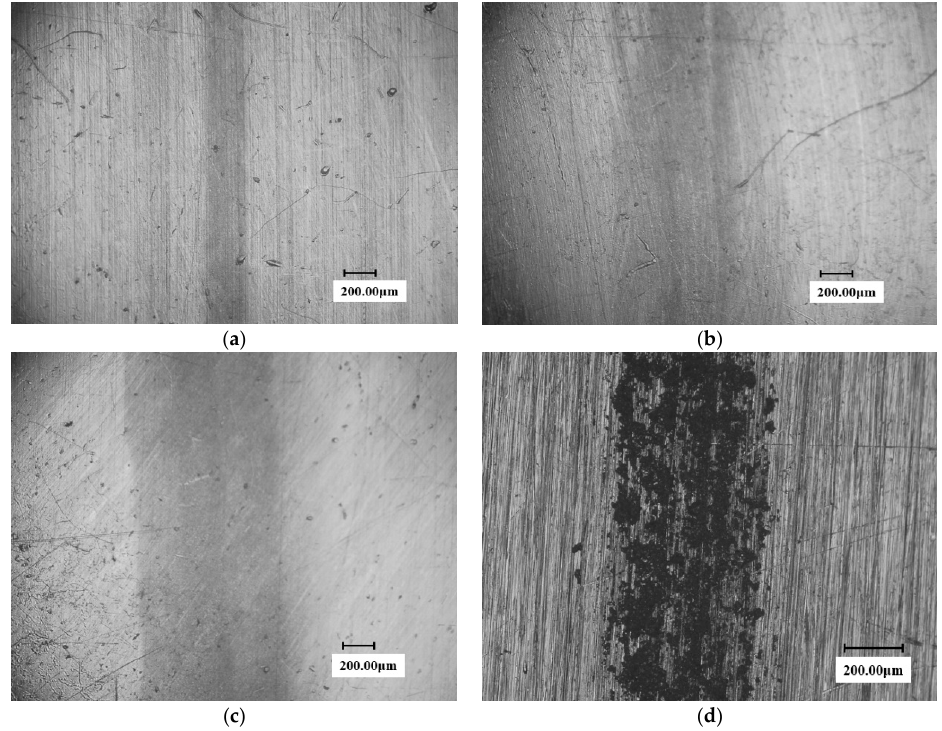
Figure 8. Surface micromorphology of cladding samples at different time. ( a ) 30° sample (erosion trace width: 290 μ m); ( b ) 60° sample (erosion trace width: 600 μ m); ( c ) 90° sample (erosion trace width: 800 µ m); ( d ) solid solution strengthened 90 ◦ sample 60 min (erosion trace width: 660 µ